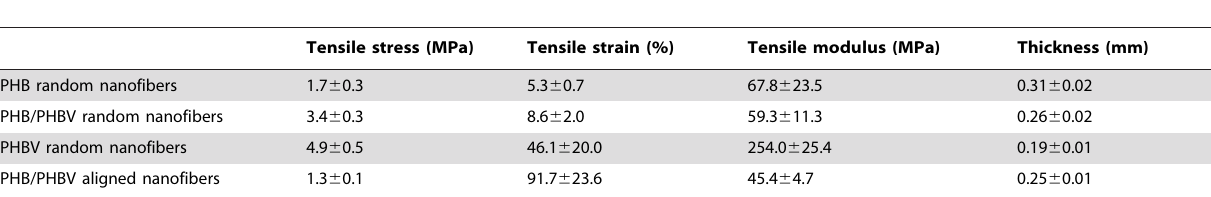
Table 1. Mechanical properties of PHB, PHBV and PHB(50)/PHBV(50) random and uniaxially oriented nanofibers.